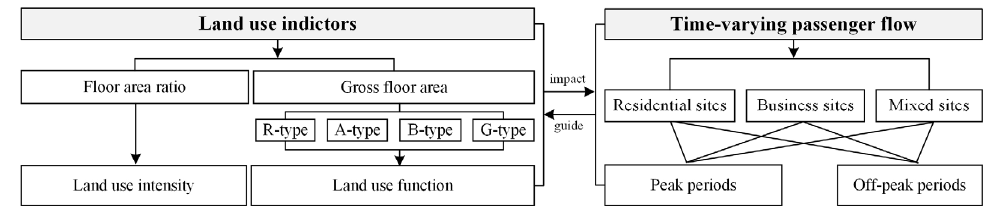
Figure 11. Results